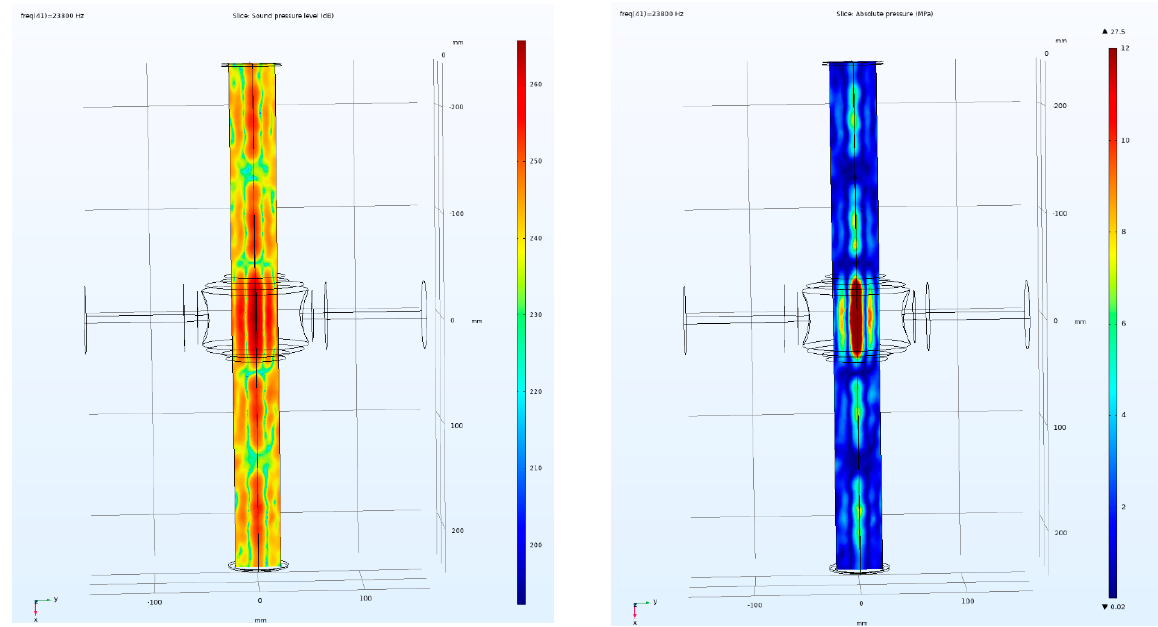
Figure 4. Acoustic pressure model ( left ) and full system pressure ( right ).